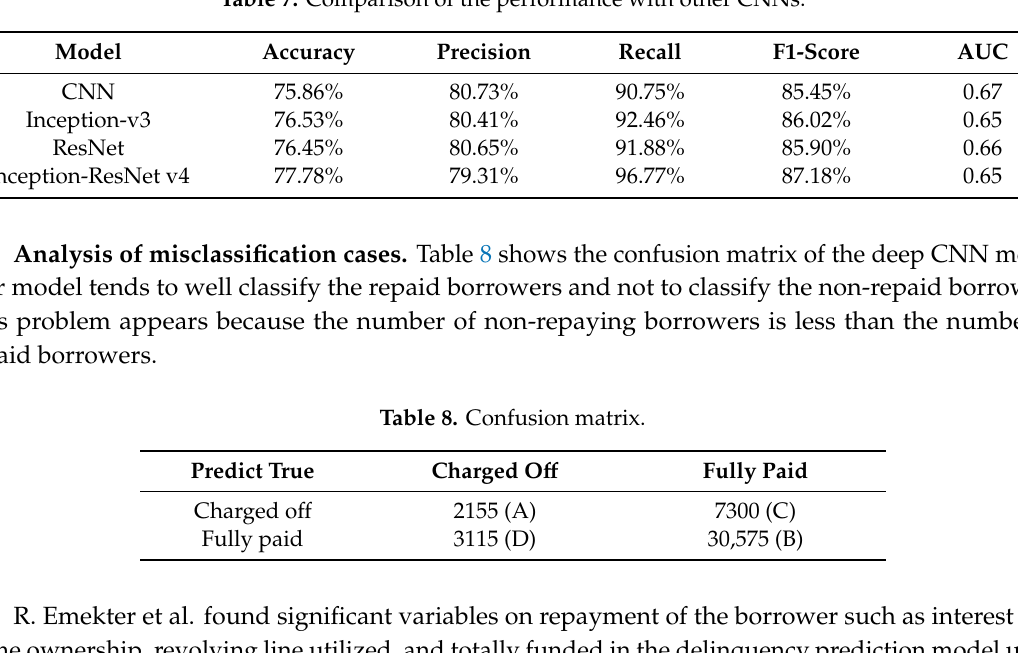
Table 7. Comparison of the performance with other CNNs.